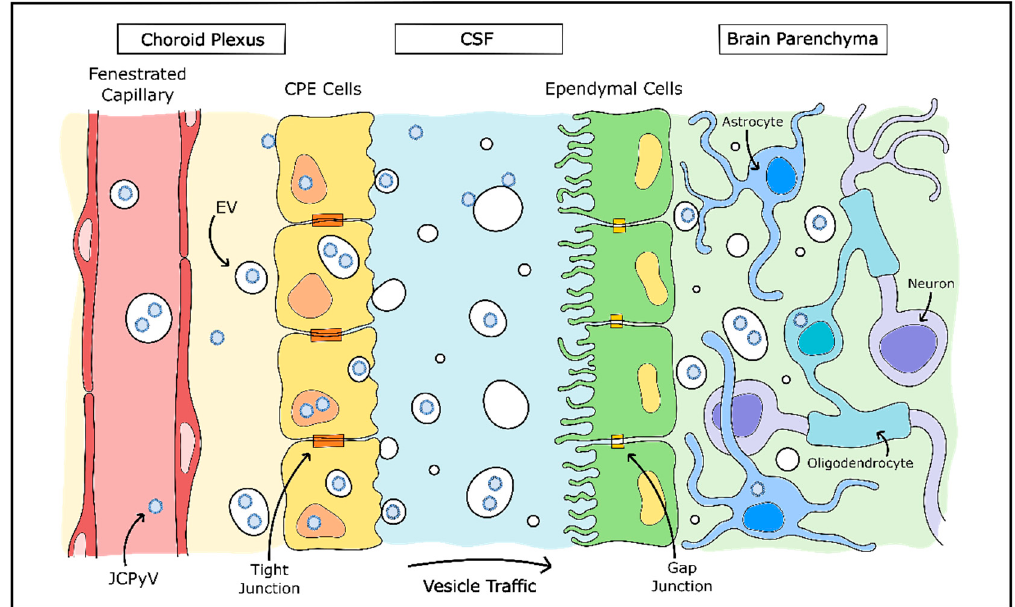
Figure 3. Model of JCPyV CNS entry by choroid plexus. Evidence suggests JCPyV may utilize extracellular vesicles (EVs) in entry of the CNS. A model proposed by O’Hara et al. theorizes JCPyV may pass into the stroma from the bloodstream as either free virions or enclosed in capsules. JCPyV is then able to infect choroid plexus epithelial (CPE) cells which package and release the virions in EVs into the CSF. JCPyV-containing EVs then enter the brain parenchyma and infect glial cells without necessitating the use of the LSTc cellular entry receptor. Adapted from [194].